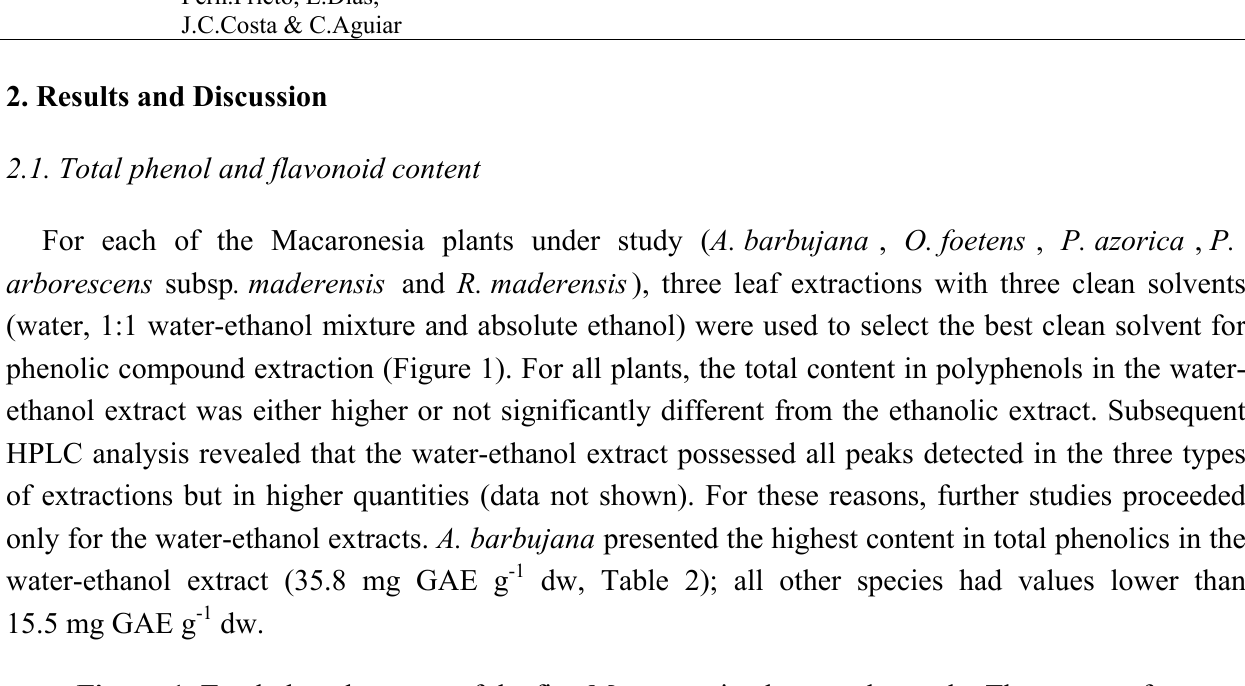
Figure 1. Total phenol content of the five Macaronesia plants under study. The extracts for the three types of solvents were evaluated for each plant: white bar- water; grey bar- water:ethanol (1:1); black bar- ethanol. Vertical bars represent ± SD. * - significantly different extractions at p <